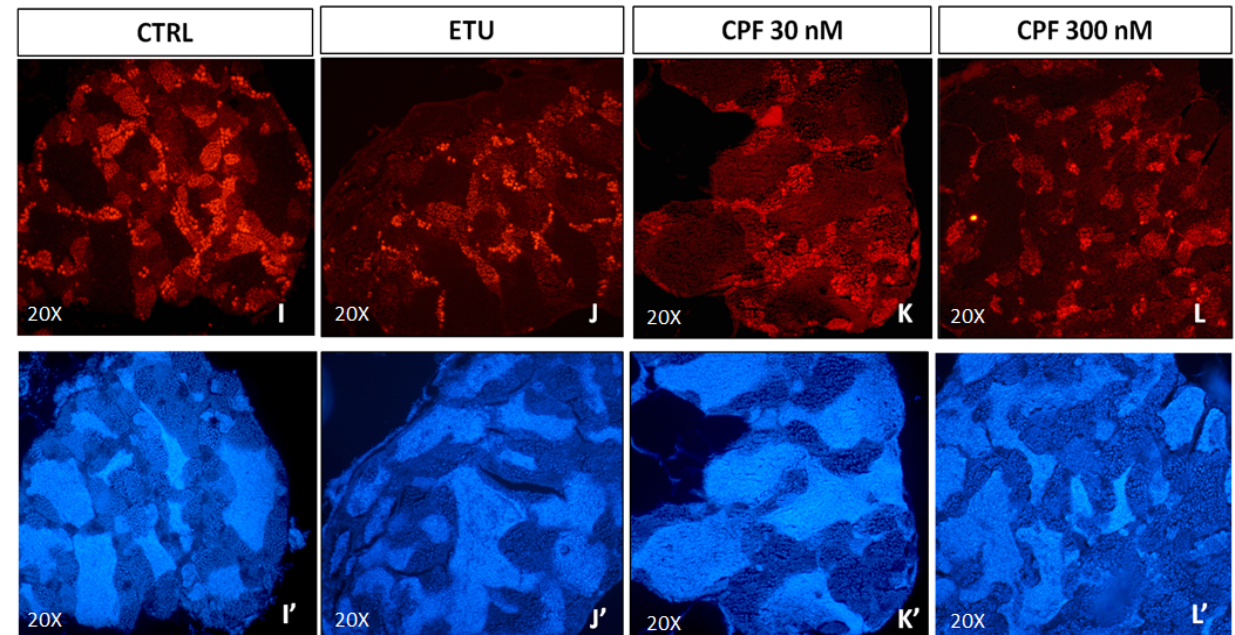
Figure 7. Developmental and long-life exposure to ETU and CPF impairs Steroidogenesis in adult zebrafish. ( A – F ) Expression levels of mRNAs of steroidogenic enzymes ( cyp11a1 , cyp17a1 , hsd17b3 , cyp11c1 , hsd11b2 , cyp19a1a ). RT-qPCR analyses were performed on zebrafish adult testes (N° = 3 testis/group). Data analysis was conducted as described in M&M section. Data are reported as fold change values calculated as a ratio between average relative gene expression in treated and control, after normalization on β -actin mRNA. Mean and standard deviation are reported. Significant difference from the control group is indicated by * p < 0.05, ** p < 0.01. One-way ANOVA (post hoc test: Dunnett’s) was used. ( G , H ) Testosterone and estradiol levels detected by ELISA assay on zebrafish adult exposed vs. CTRL testes ( n = 3 testis/group). Significant difference from the control group is indicated by * p < 0.05. ( I – L ) Staining for Er α on zebrafish testis sections (20× magnification), showing the alteration of Er α level in exposed groups ( I’ – L’ ) DAPI staining to visualize nuclei.